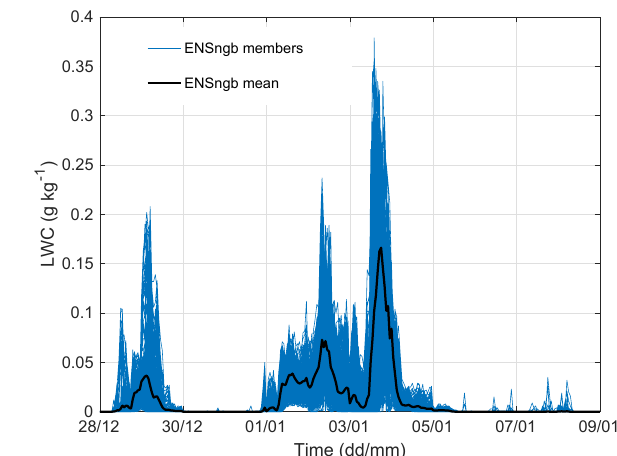
Figure 8. Site A. Forecasted liquid water content in gkg − 1 using the ENSngb approach.